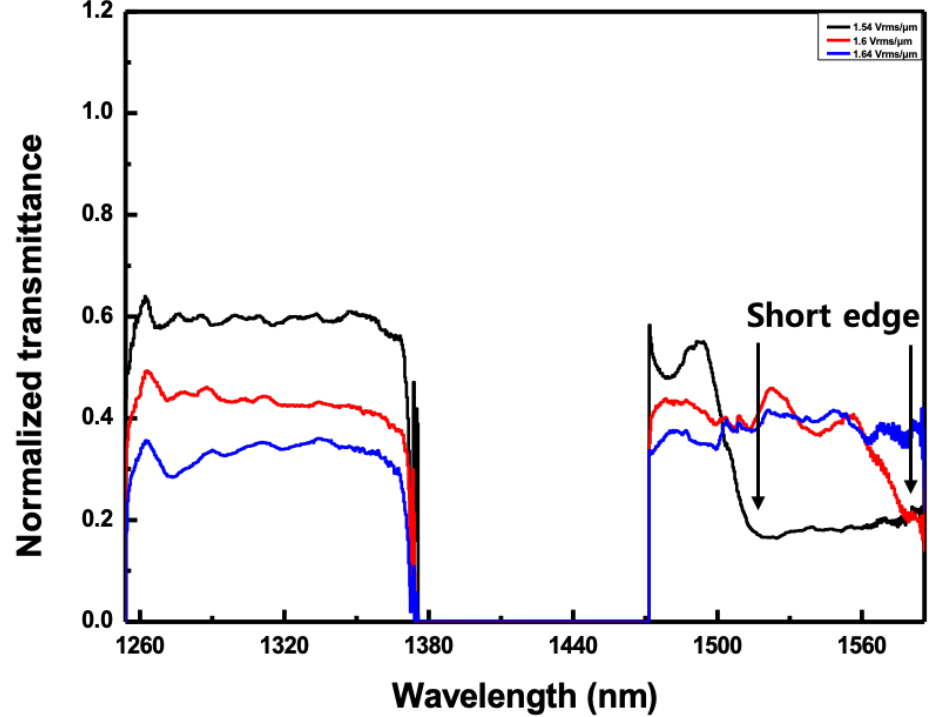
Figure 8. The normalized transmitted spectra according to the applied electric field more than 1.54 V rms /μm when the angle of incidence to the CLC cell was fixed to 36 o .